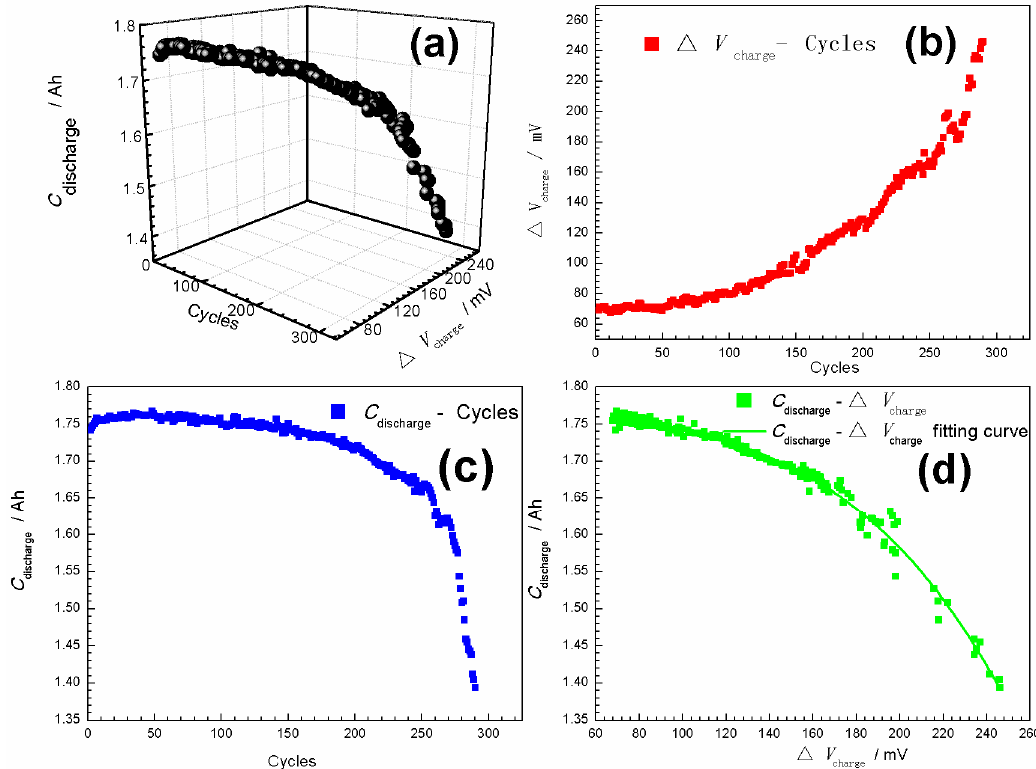
Figure 2. 3D diagram for a Ni-MH battery in the charge-discharge test at 1.0C (AA-type, 1.8 Ah, 1.2 V): ( a ) 3D diagram and ( b ), ( c ) and ( d ) projection of the 3D